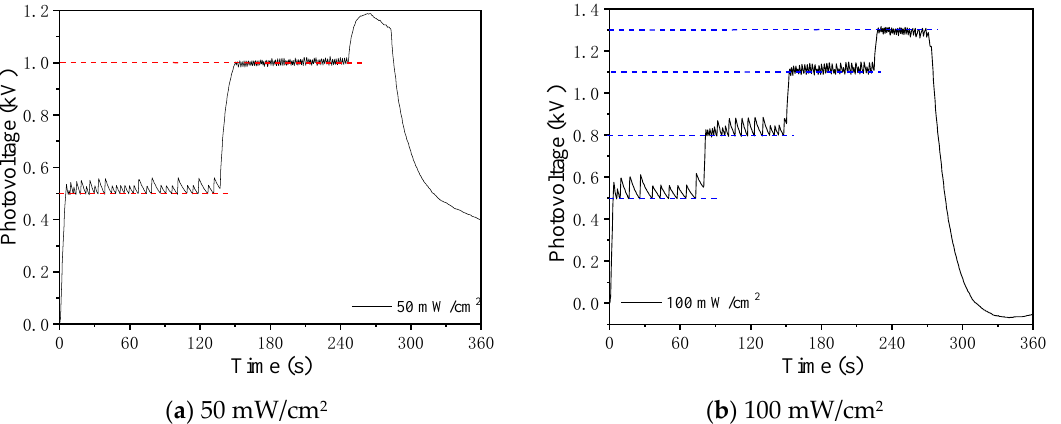
Figure 21. Photovoltage control curves of a single PLZT ceramic with multiple target values under different light intensities: ( a ) 50 mW/cm 2 , ( b ) 100 mW/cm 2 .